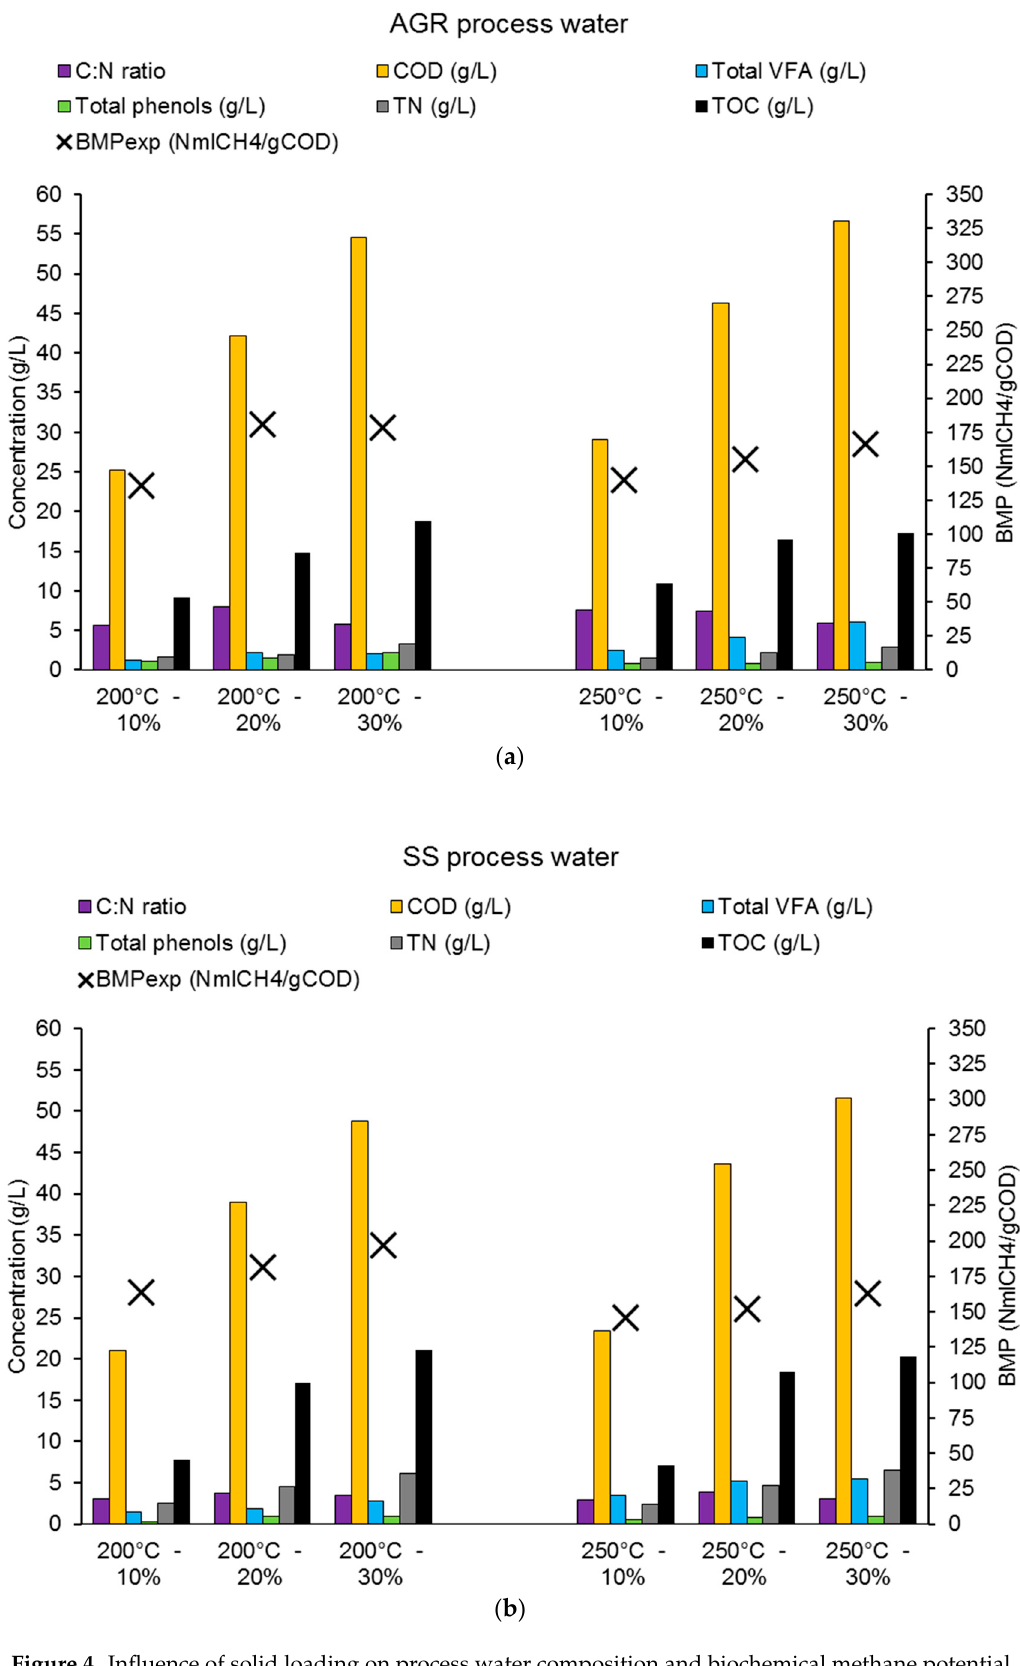
Figure 4. Influence of solid loading on process water composition and biochemical methane potential (BMP) for ( a ) AGR at 200 and 250 °C, and ( b ) SS at 200 and 250 °C.